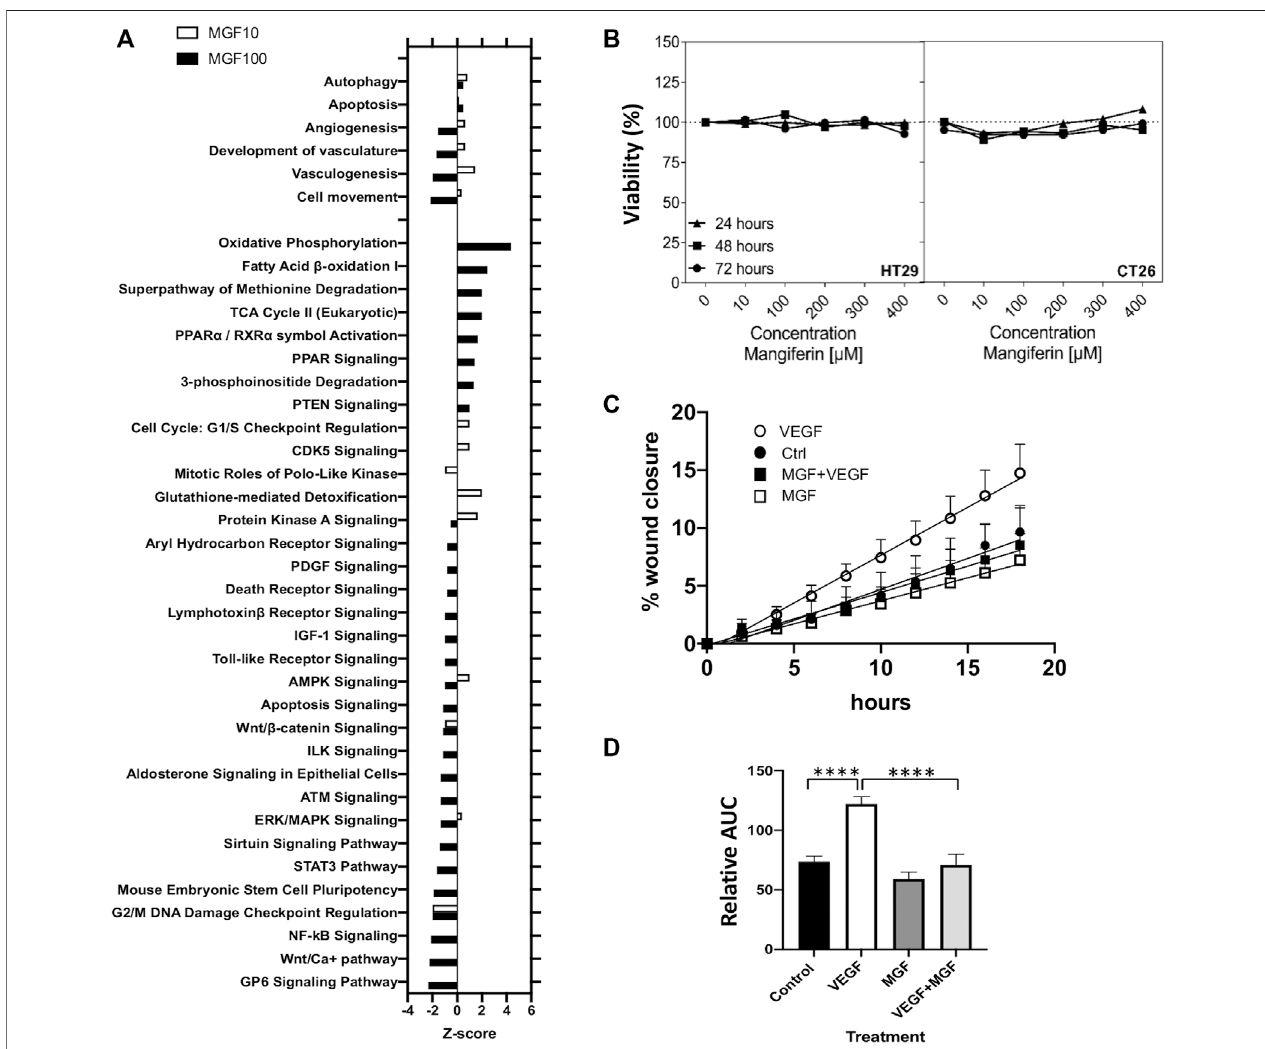
FIGURE 3 | MGF treatment inhibits prometastatic tumor cell motility in a wound scratch assay in vitro without adverse toxicity. (A) Z-score barplot of most signi fi cantly enriched disease functions and canonical pathways (B) Assessment of cell viability by MTT assay of HT29 cells and CT26. WT colorectal cells after 24, 48 and 72 h treatment with MGF. (C) Realtime image quanti fi cation (0 – 18 h) of in vitro migration and wound closure of HT29 cells in the presence of 10 ng/ ml VEGF, 400 µM MGF a combination thereof or solvent matched controls. (D) Bar plot quantitation of the wound closure after cell scratching following different treatments by measuring each area under the curve in Figure 3C (0 – 18 h). Data are given as mean ± SD ( n (cid:2) 3). Statistics were calculated with 1-way ANOVA *** p <